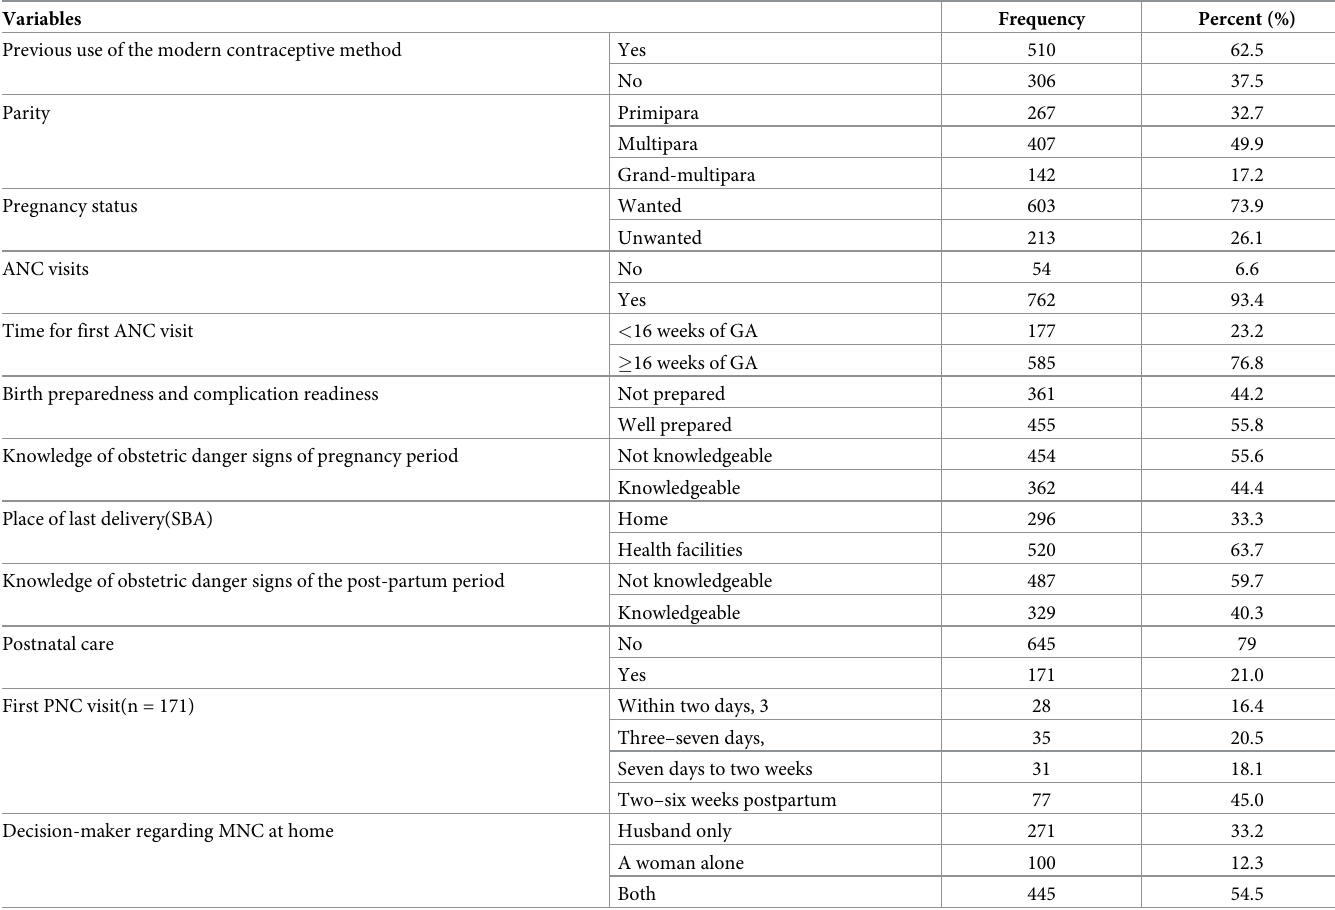
Table 2. Obstetrics and maternal health care service characteristics of mothers who have given birth in the last 12 months in the Hadiya zone,